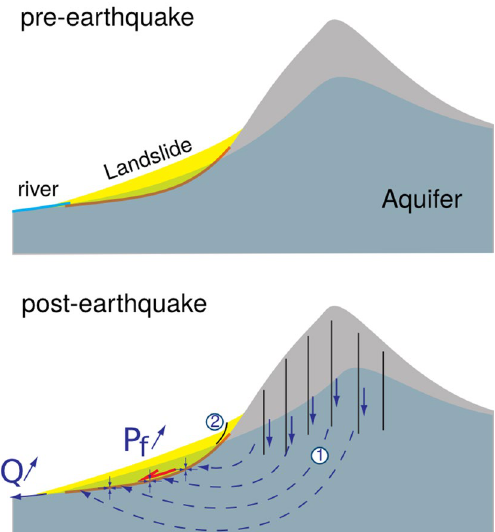
Figure 7. Mechanisms of co-seismic excess pore-water pressure and subsequent transport to the landslide zones (adapted from 16 ): (1) Subvertical cracks open during the earthquake, and allow the drainage of water from sediments compaction down to the aquifer, (2) internal landslide reconfiguration, whereby the upslope deformation loads the downslope area, increasing the pore pressure. P f denotes the fluid pressure at the landslide basal interface, and Q denotes the river